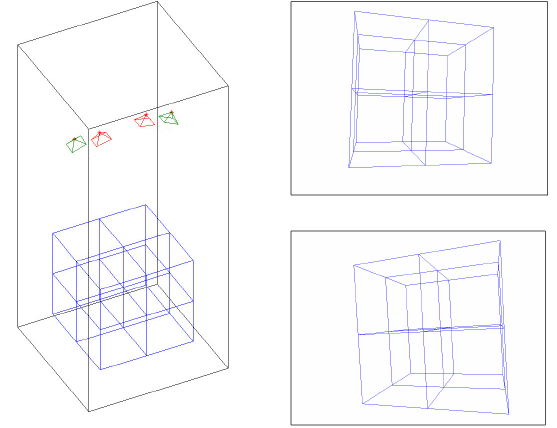
Figure 5. Example of simulated data.